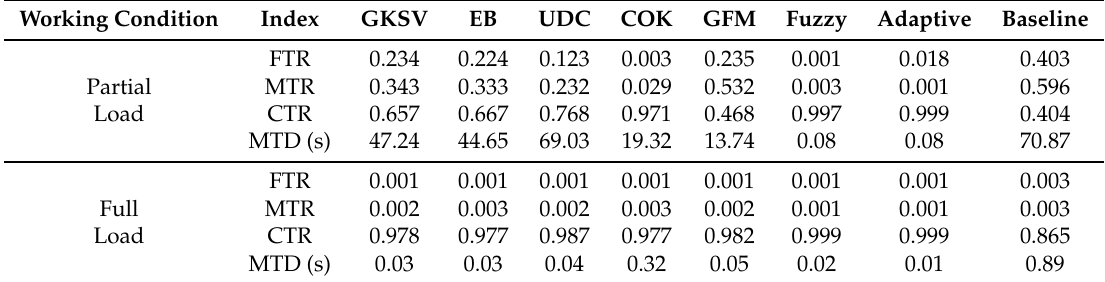
Table 7. Comparison of the different control strategies applied to the wind turbine benchmark. GKSV, Support Vector machine based on a Gaussian Kernel; EB, Estimation-Based; UDC, Up-Down